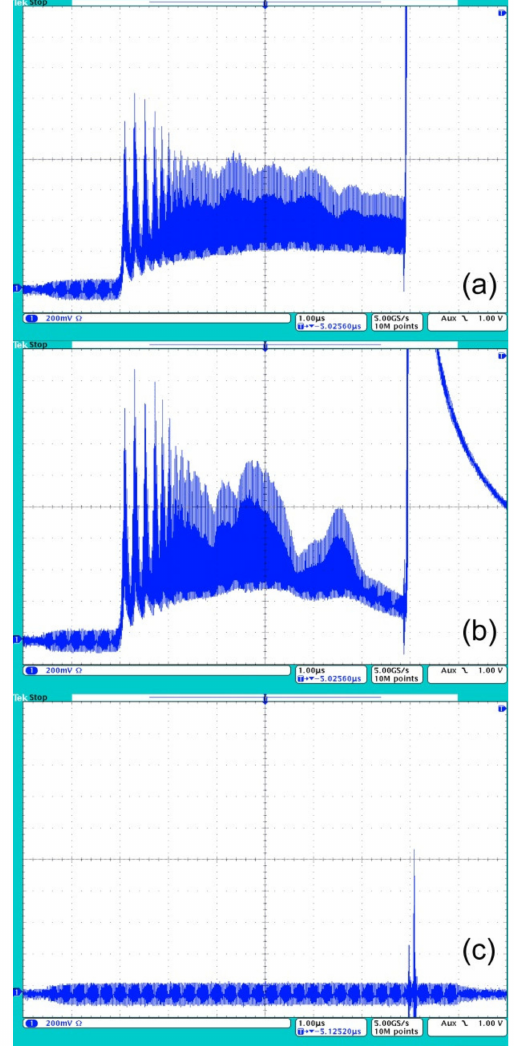
Figure 7. The “long train” envelope irregularities and generation failure: ( a ) Pump repetition rate is 210 Hz, the envelope shape deviates from flat; ( b ) 230 Hz, the envelope decays down to the switching moment and the “short train” is less intensive; ( c ) 250 Hz, generation failure, parasitic electrical interference signal is caused by AML signal